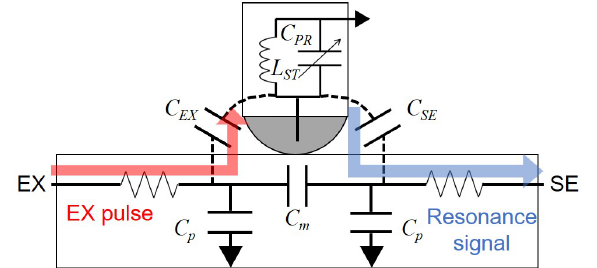
Figure 16. Electrically coupled resonance stylus. EX pulses are transmitted to the inside LC circuit and resonance signals are transferred to the coupled SE line. C m is the mutual capacitance, C p is the parasitic capacitor of EX and SE lines, C EX is the coupling capacitance between EX line and stylus, and C SE is the coupling capacitance between SE line and stylus. L ST and C PR are inductance and capacitance of the resonance circuit in the